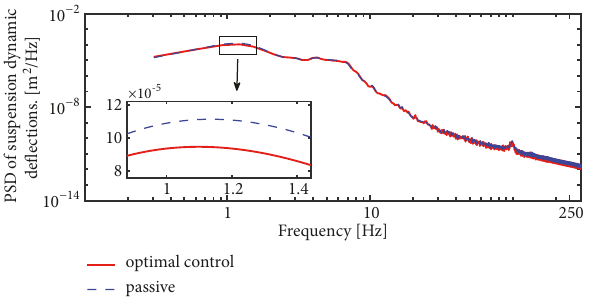
Figure 8: Frequency response of suspension dynamic deflections.